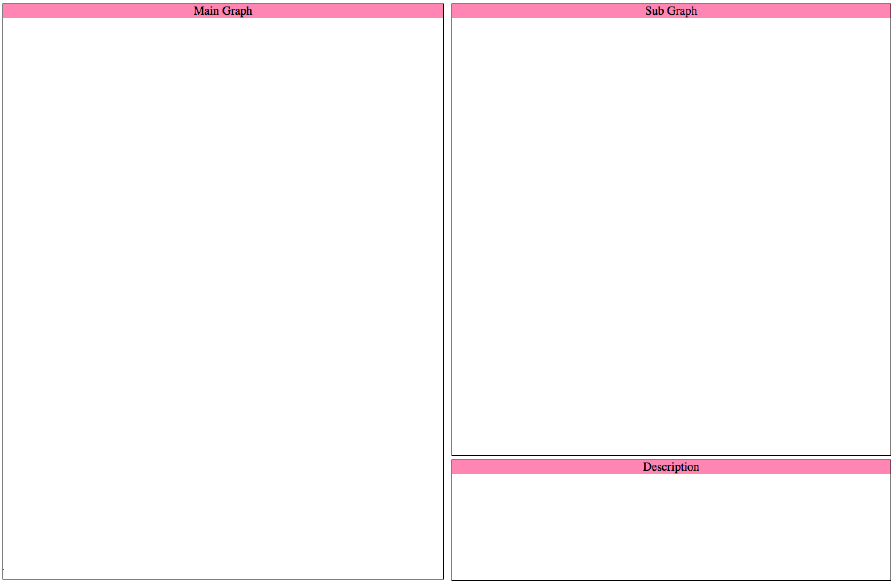
Figure A1. An HTML skeleton layout to visualize the main and sub